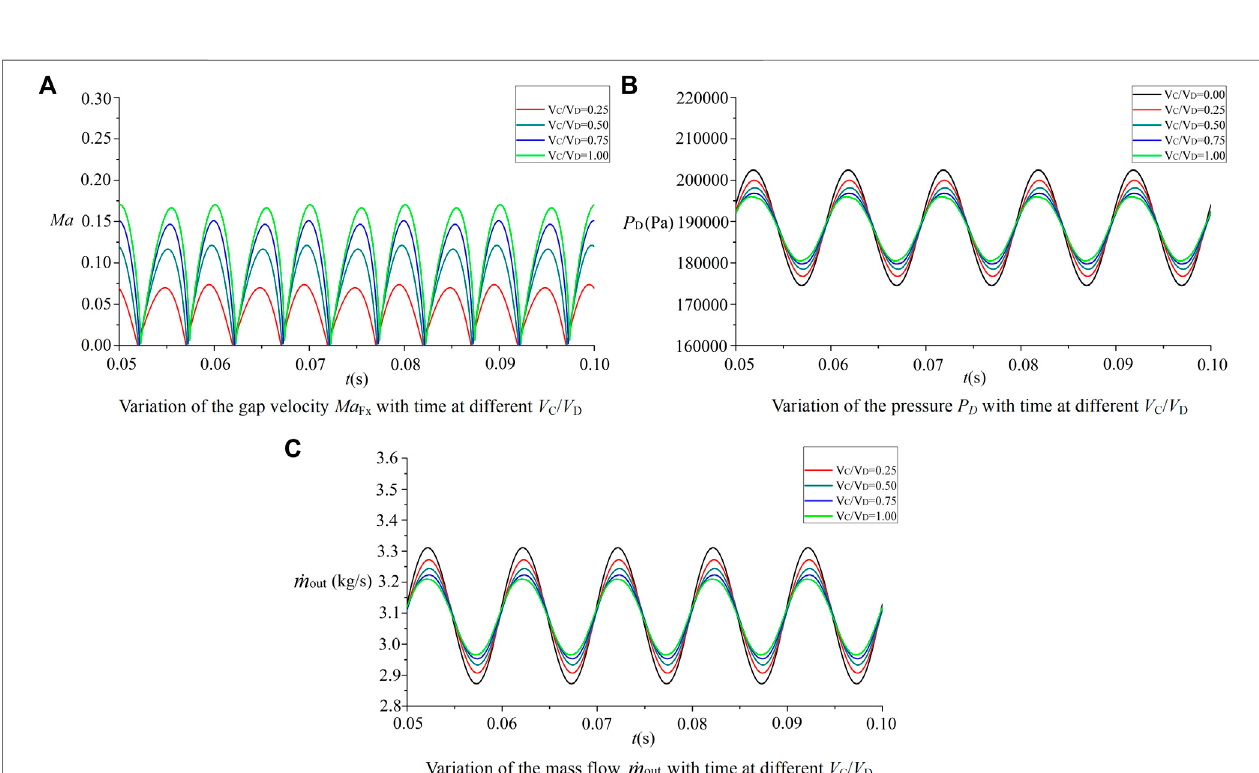
FIGURE 7 | Parameter variations under the different volume ratios V C / V D